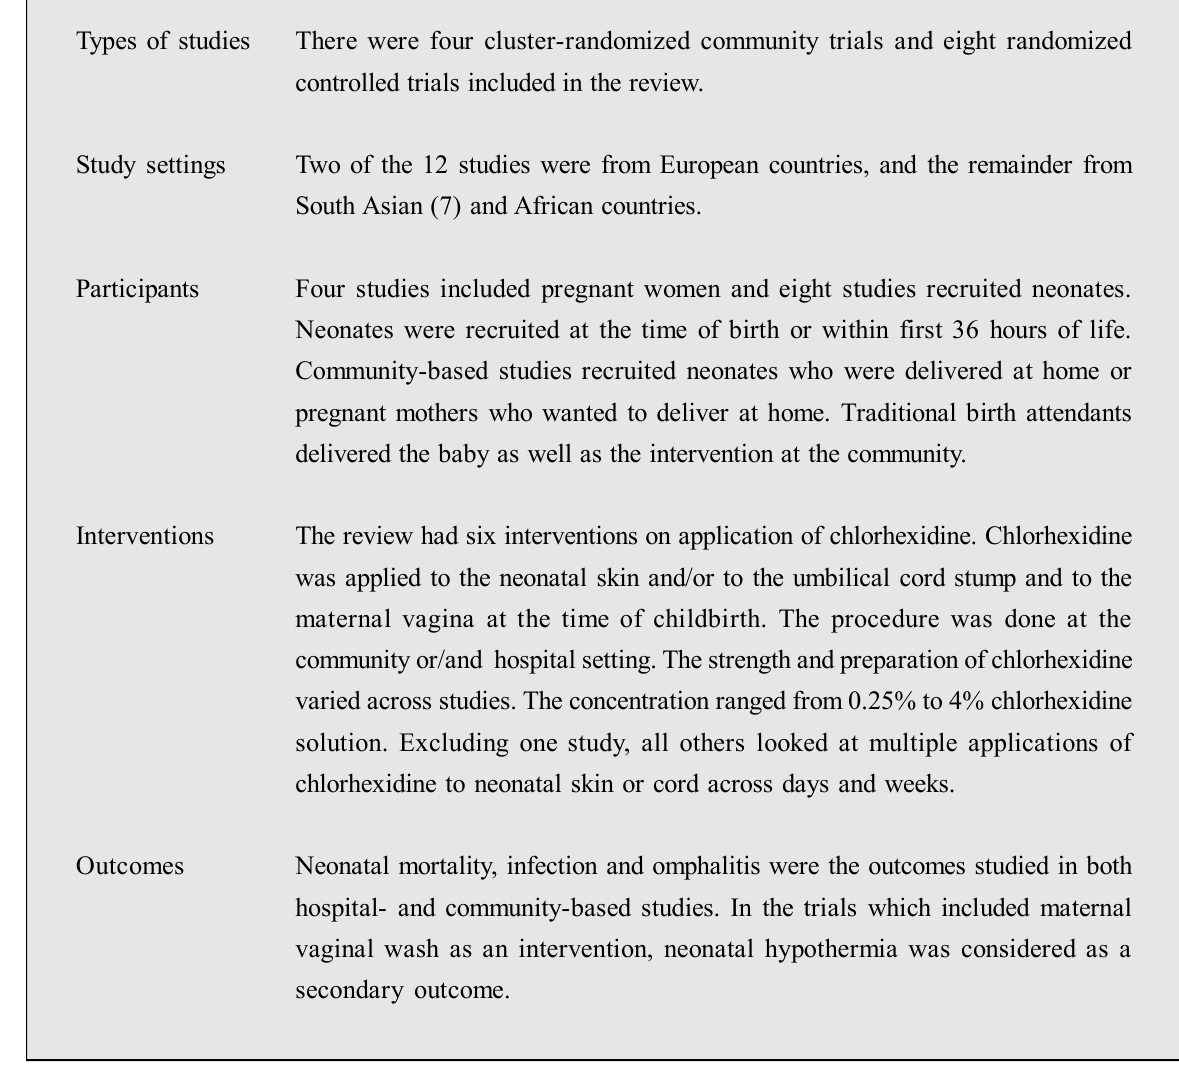
Table 1 provides a summary of the key findings of the review. Application of chlorhexidine to the neonatal skin or cord did not reduce mortality for